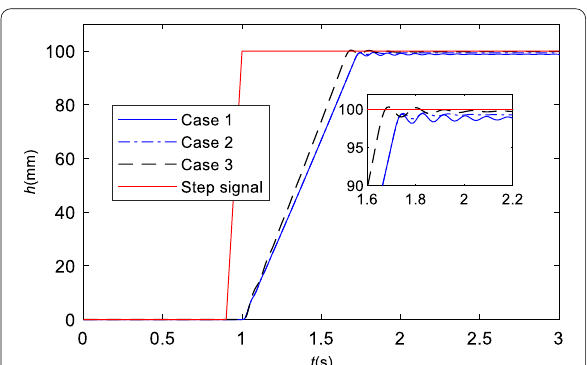
Figure 10 Comparison of response curves under the same height